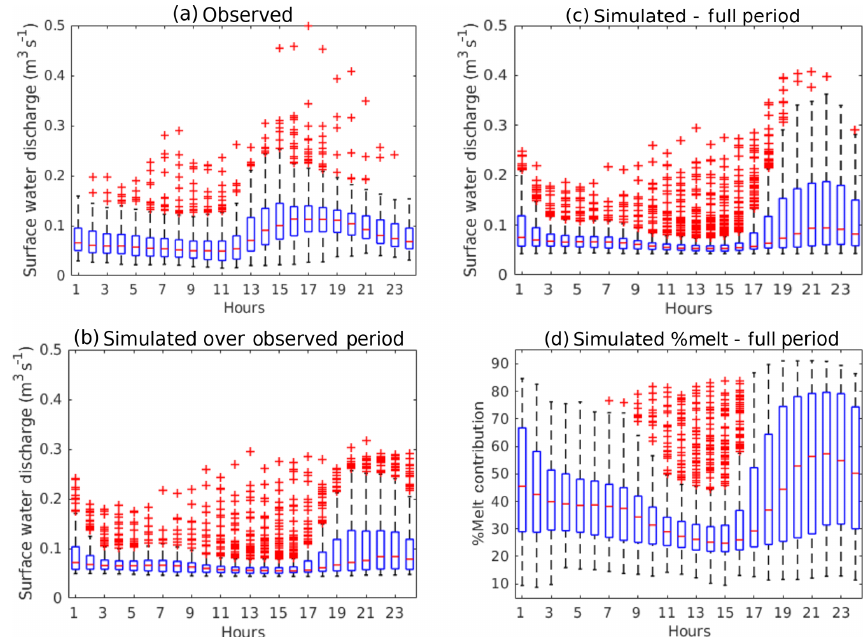
Figure 7. Box plots over local hour of day showing the 25th to 75th percentiles with boxes and maximum and minimum with whiskers for (a) observed discharge over the 9-month observation period, (b) simulated discharge over the 9-month observation period, (c) simulated discharge over the 12-month simulation period, and (d) simulated percent glacier melt contribution to discharge over the 12-month period. Simulations do capture diurnal patterns, but with an underestimated magnitude and shifted peak. Simulated percent glacier melt contributions to discharge closely mirror the simulated diurnal fluctuations in